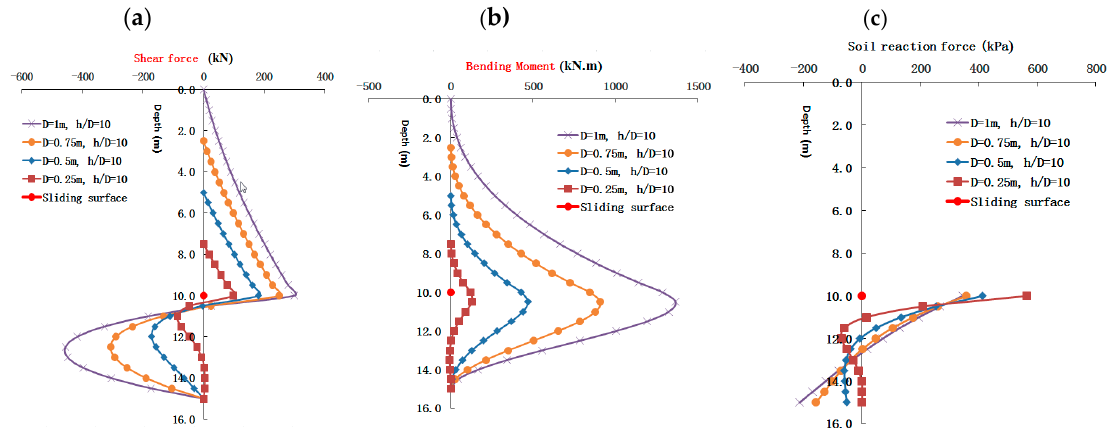
Figure 8. Calculated values of internal forces for buried-boring piles at varying depths with h / D = 10: ( a ) shear force; ( b ) bending moment; and ( c ) soil reaction force.